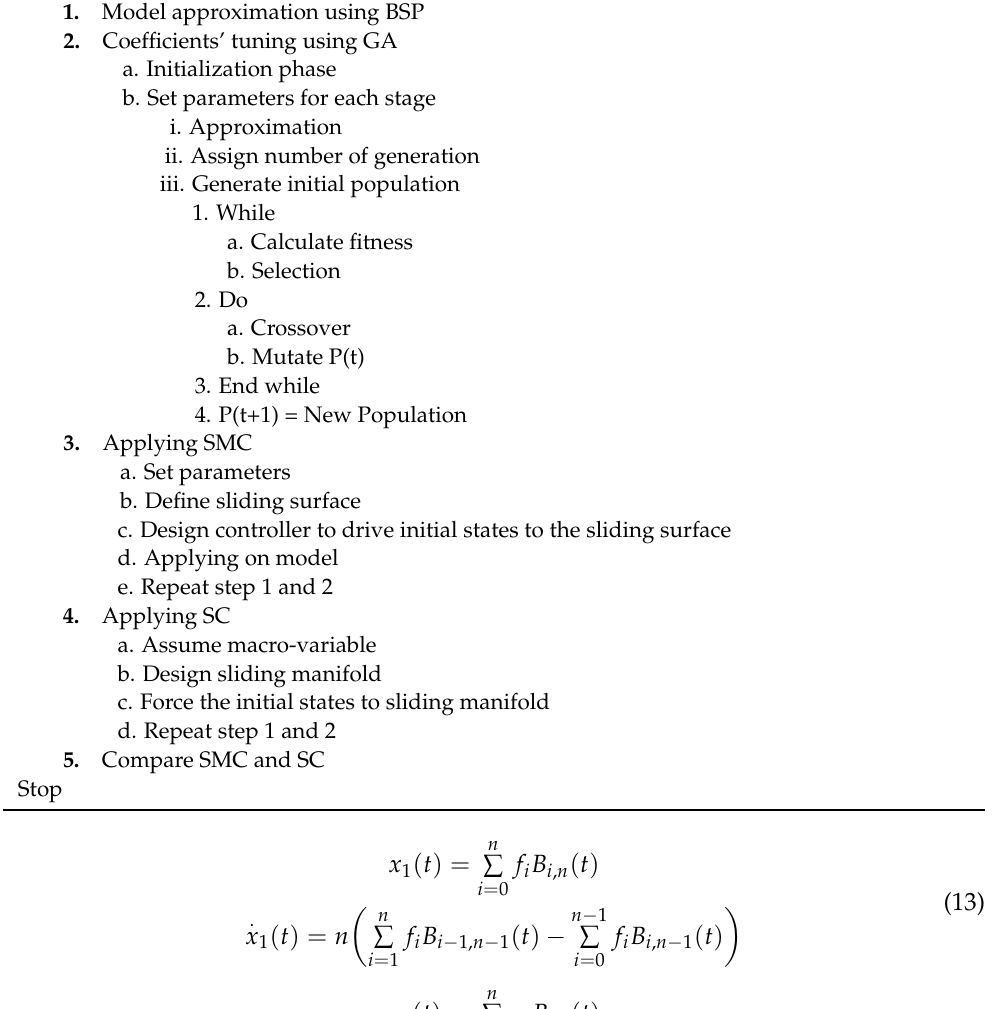
Algorithm 1 [24–27]: Model approximation using GA-tuned BSP along with a controller as the proposed